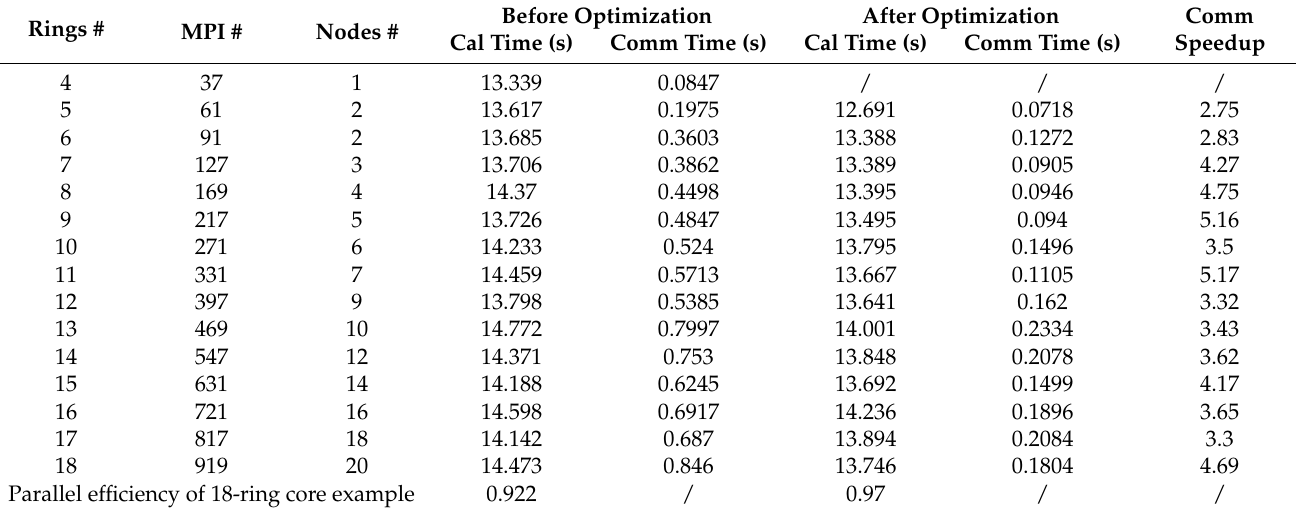
Table 6. Optimization performance on Platform 2 (48 cores per node).